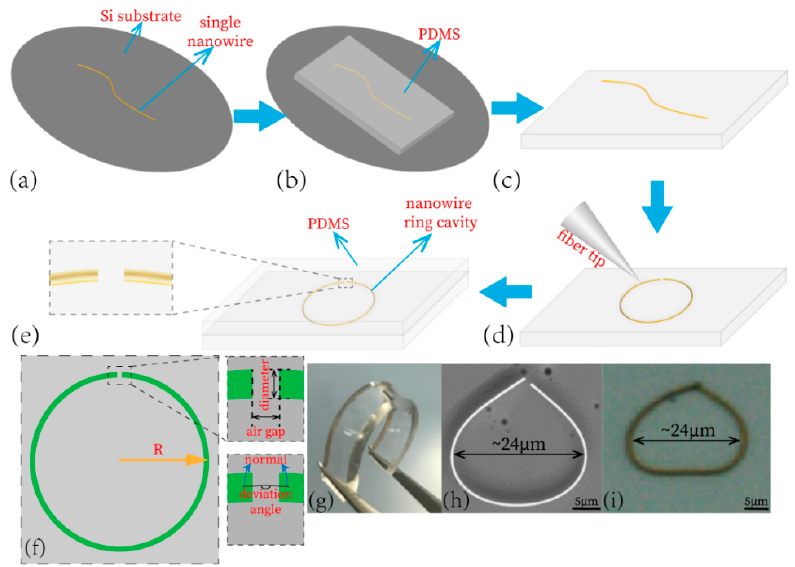
Figure 1. Preparation of sensitive elements. ( a ) Single CdS nanowires transferred to the surface of the silicon wafer. ( b , c ) The polydimethylsiloxane (PDMS) substrate is bonded to the surface of the silicon wafer, and the nanowires are transferred to the PDMS surface through intermolecular adsorption. ( d ) Manipulating nanowires with fiber optic probes to prepare sensitive elements. ( e ) PDMS substrate with sensitive cells placed in the deposition system for sensitive cell packaging. ( f ) Schematic diagram